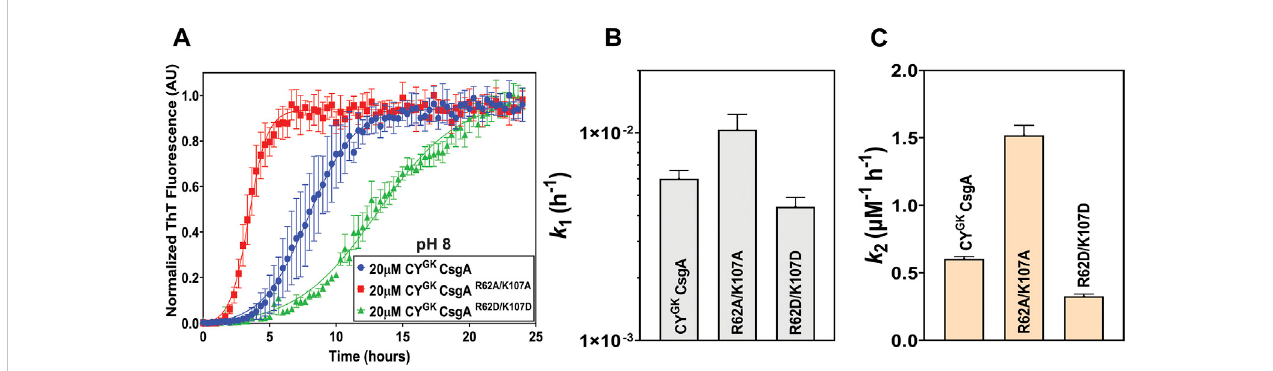
FIGURE 5 Loss of positive charge on K residues negatively impacts gatekeeping function. Analysis of aggregation kinetics of CY GK CsgA, CY GK CsgA R62A/K107A , and CY GK CsgA R62D/K107D at 37 ° C, pH 8. (A) ThT fl uorescence assay. (B) Nucleation rates k 1 of amyloidosis (log scale) and (C) Growth rates k 2 of amyloid fi ber propagation (linear scale). (Error bars represent SEM for ThT assay and SD for k 1 and k 2 of three replicates).